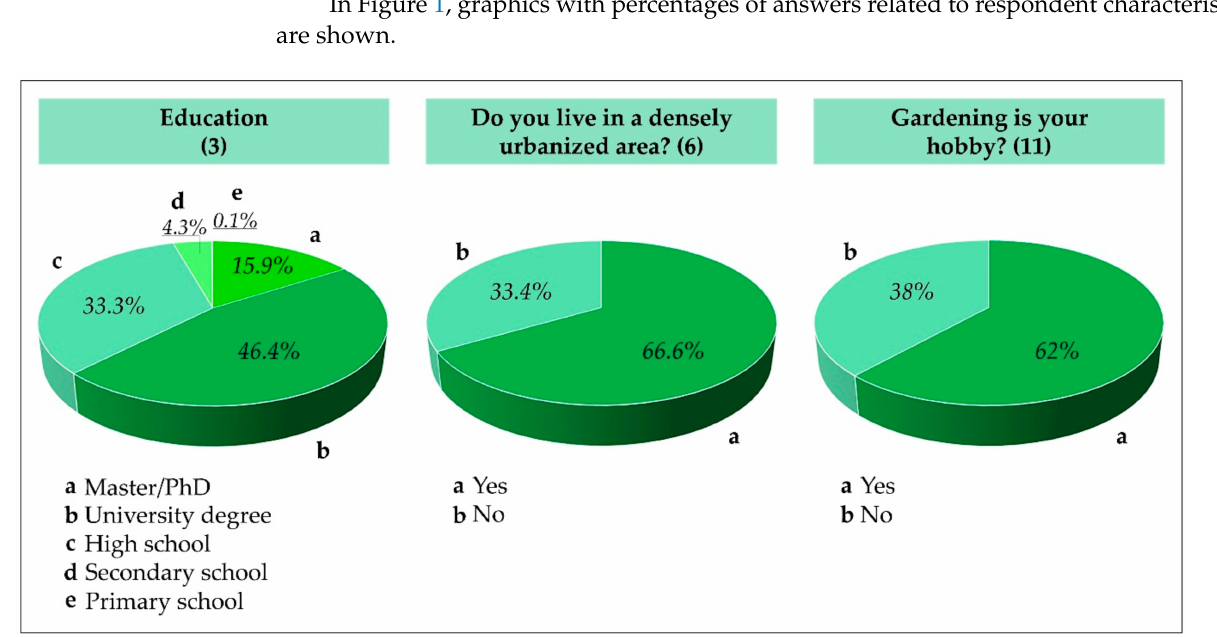
Figure 1. Respondents’ characteristics (questions 3, 6, and